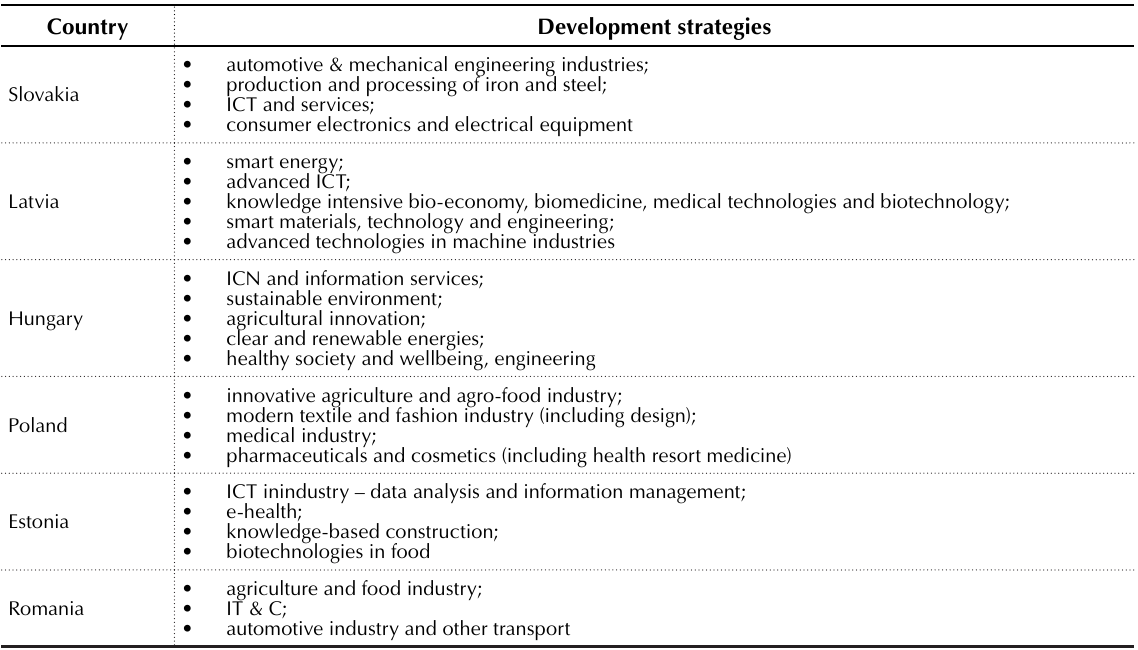
Table 3. Roadmaps of development strategies in different countries Country Development strategies